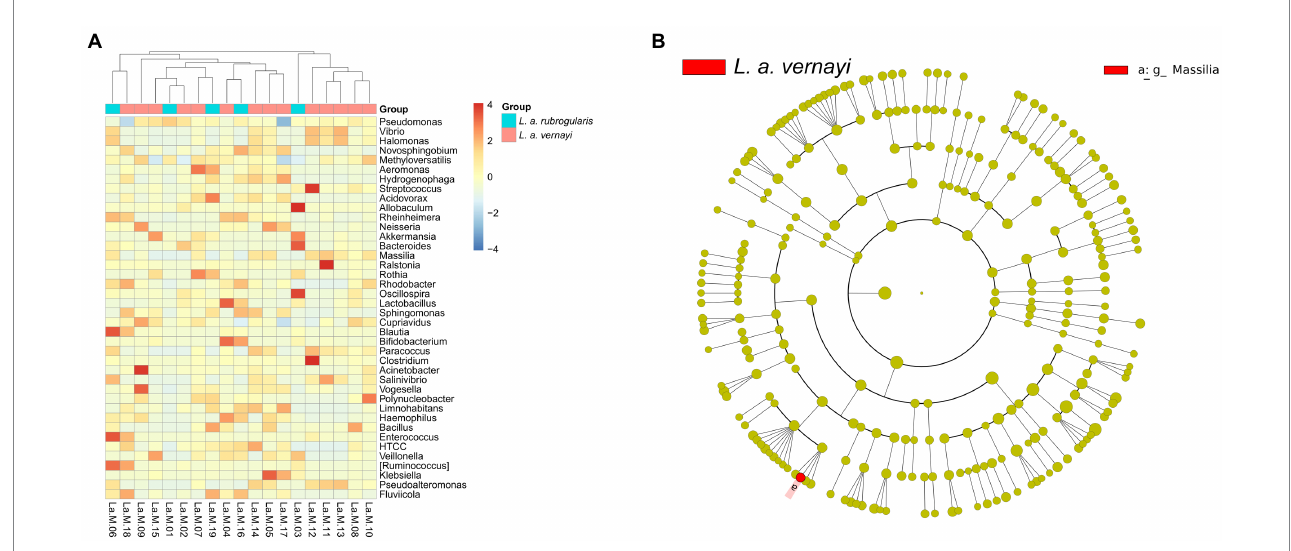
FIGURE 5 (A) Heatmap of the genus-level hierarchical clustering of the microbial community in L. a. rubrogularis and L. a. vernayi . (B) Differential microbial phylogenetic distribution was visualized by the cladogram. The taxonomic branch diagram shows the taxonomic hierarchy of the main taxa from phylum to genus (from inner ring to outer ring) in the sample